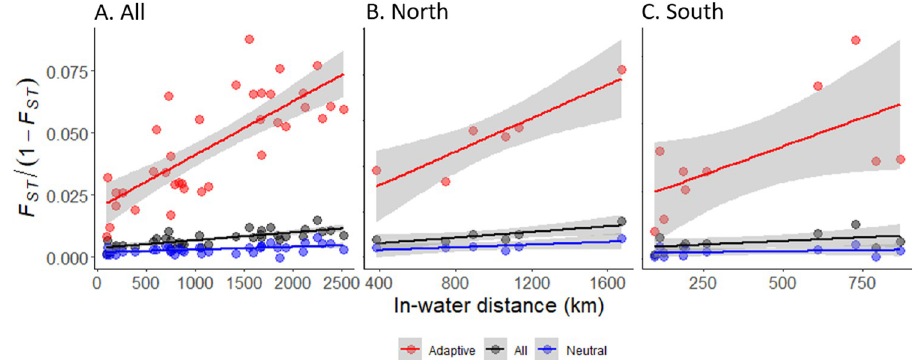
Fig 3. Test for isolation by distance for all collection sites (A), northern collection sites (B), and southern collection sites (C). Correlation between in-water distance and linearized F ST using all SNPs in black, putatively neutral SNPs in blue, and putatively adaptive SNPs in red.